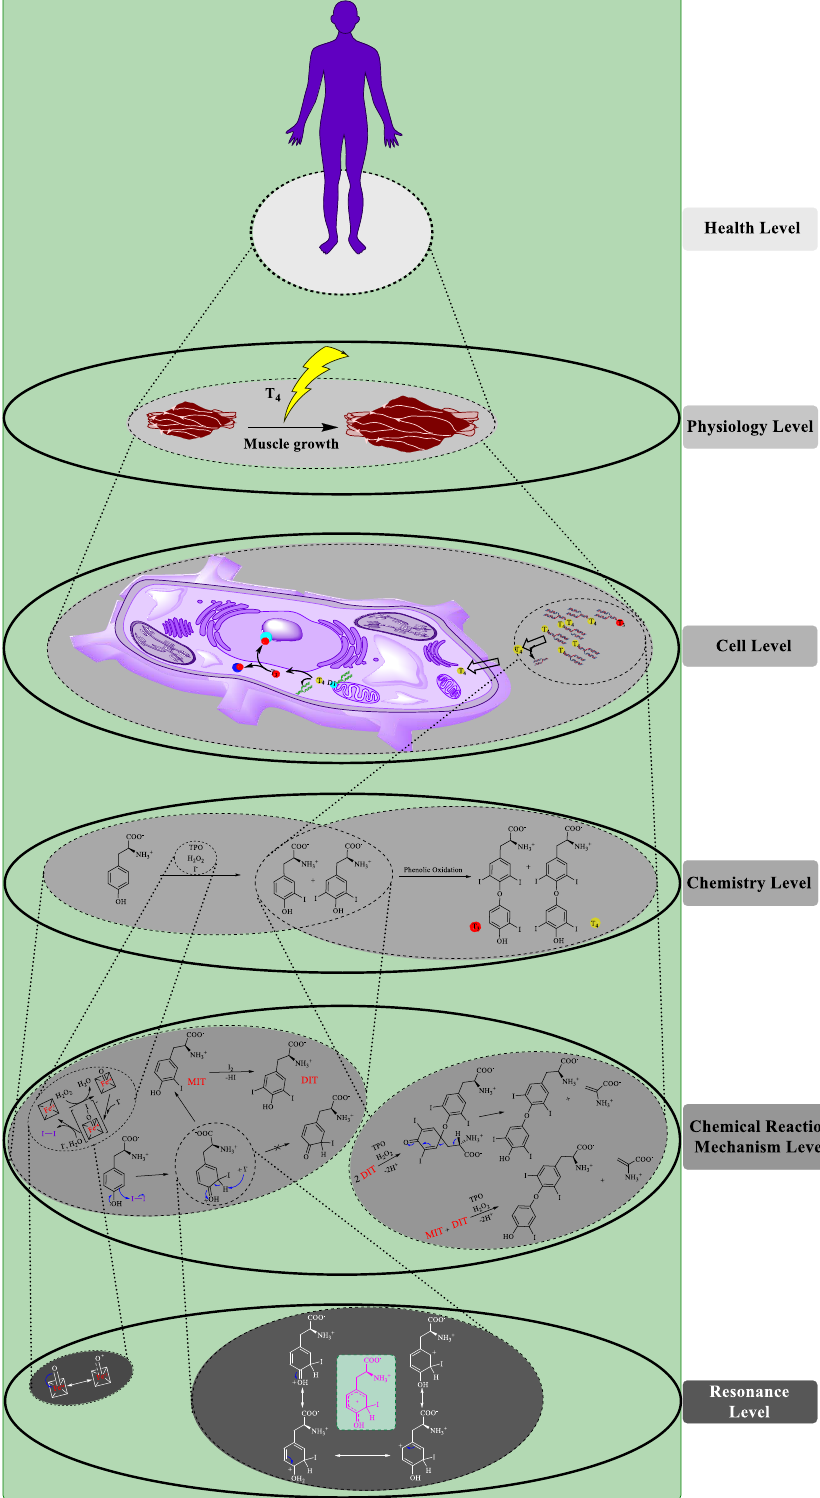
Figure 8 . The Baumkuchen model of the initially “flat” biochemical scheme depicted in Figure 6. Here, the different layers are clearly separated. Producing mechanisms within layers are shown in straight arrows, and underlying mechanisms depicted with cones, similar to the model in Figure 5. Please note that the Baumkuchen model avoids arrows between layers. If shown, these arrows may serve as heuristic tools rather than indicators of interlevel causation.